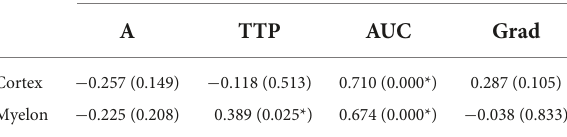
TABLE 10 Pearson correlation coefficient between the time interval of TIC analysis and TIC